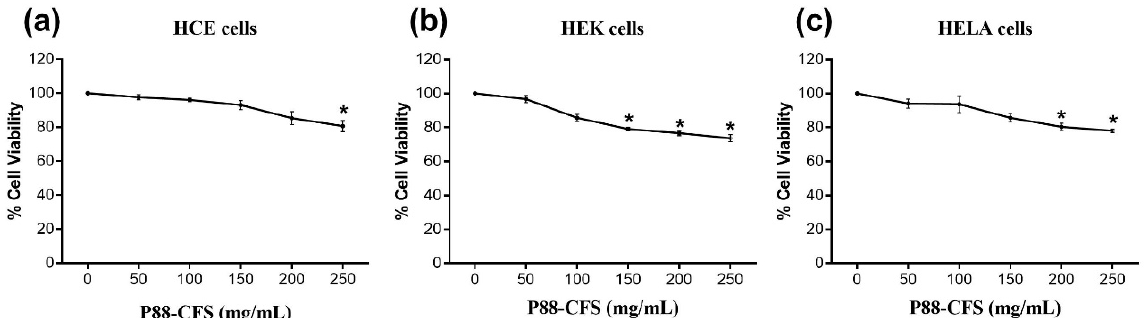
Figure 2. Percentage viability of ( a ) HCE, ( b ) HEK, and ( c ) HeLa cells treated with different concentrations of P88-CFS. MTT assay was performed to determine the percentage of cell viability in the presence of P88-CFS. Cells were seeded in 96 well plates at a density of 4 × 10 4 and treated with P88-CFS for 24 h. Data are represented as the means ± SD of 3 independent experiments. * p < 0.05 compared with Control.